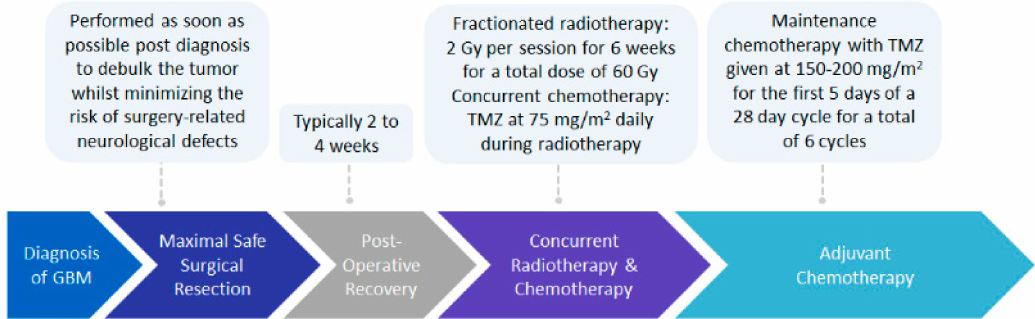
Figure 1. Overview of the current standard of care treatment for newly diagnosed GBM. Patients are treated according to what is commonly known as the Stupp protocol. Patients undergo the maximal safe surgical resection to remove as much of the tumor as possible, followed by a 2–4 week post-operative recovery period. Once patients have recovered from surgery, they undergo radiotherapy for a total dose of 60 Gy, with concurrent TMZ chemotherapy administered daily. Patients then receive maintenance chemotherapy with TMZ alone for a further six months. At the cessation of maintenance chemotherapy, the monitoring of patients for response to therapy and subsequent treatment options is at the discretion of the